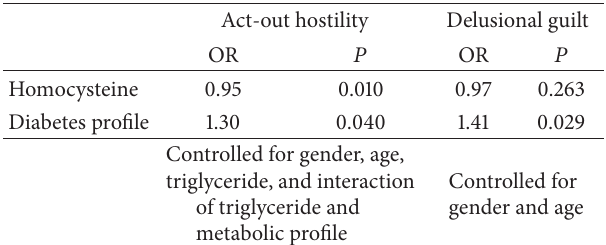
Table 3: Estimates of the binomial generalized linear model for the subscales of HDHQ.